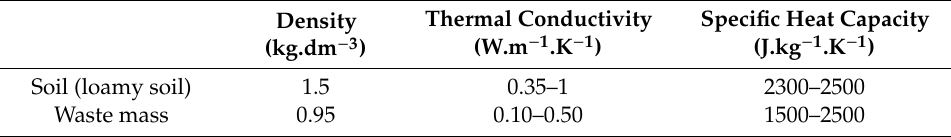
Table 1. Thermal properties for the medium studied.